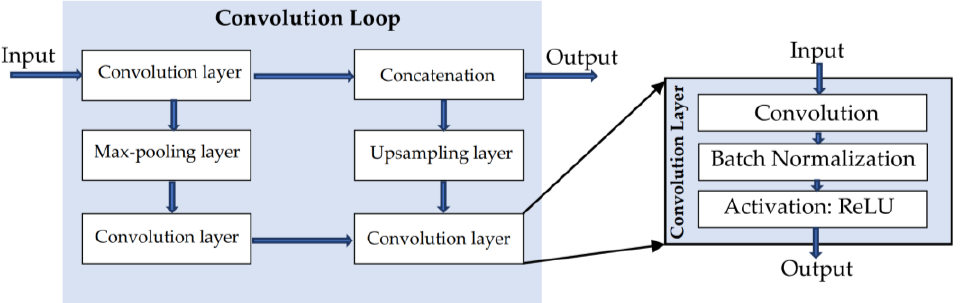
Figure 4. Convolution